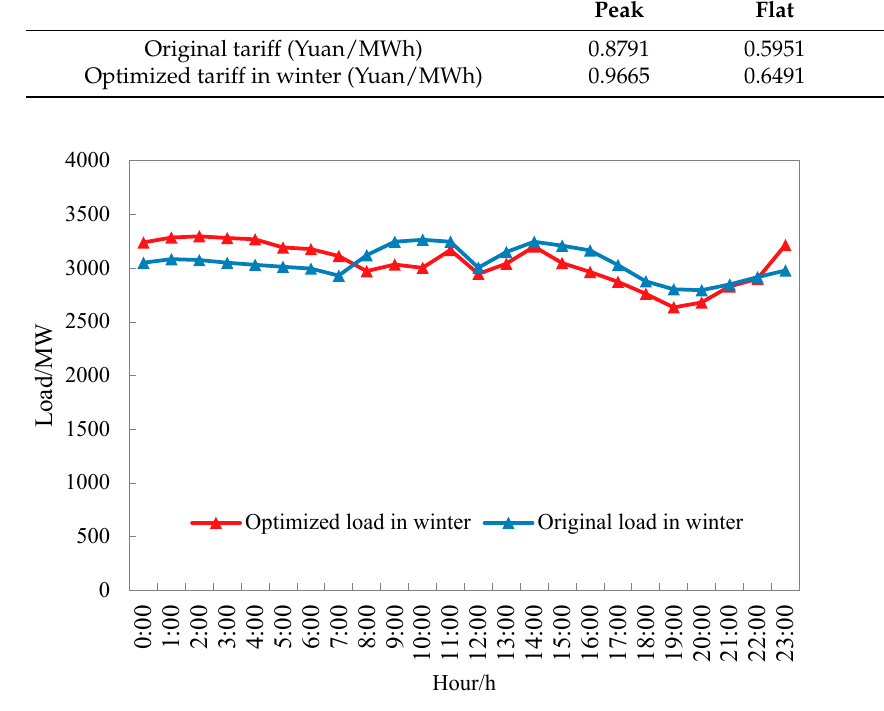
Figure 6. The load optimization results in winter.